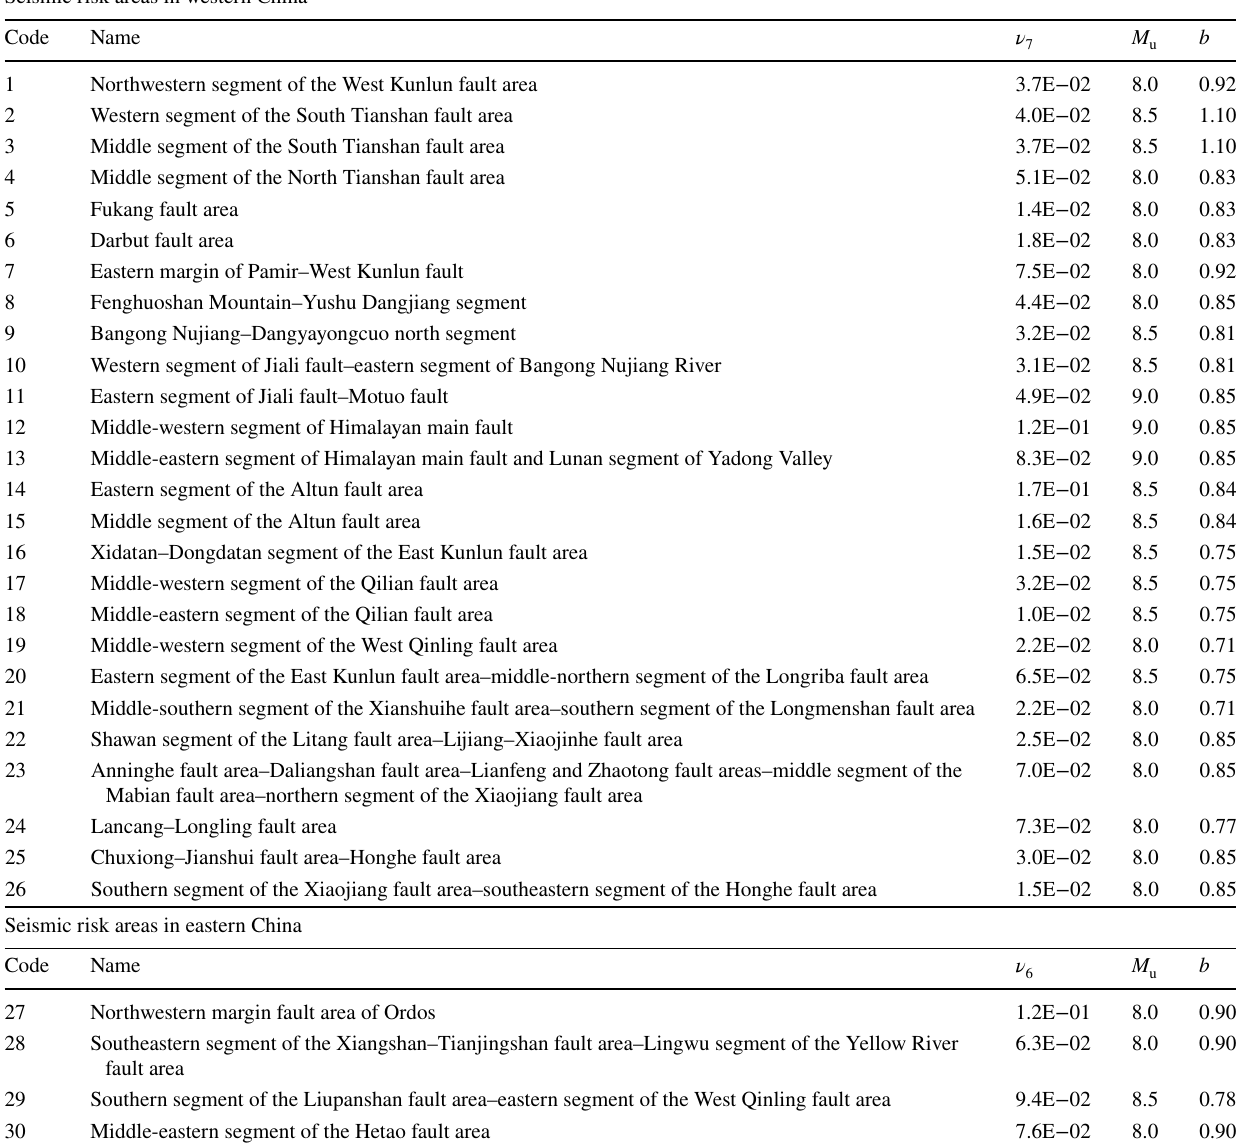
Table 2 Seismicity parameters in the seismic risk areas of China’s mainland Seismic risk areas in western